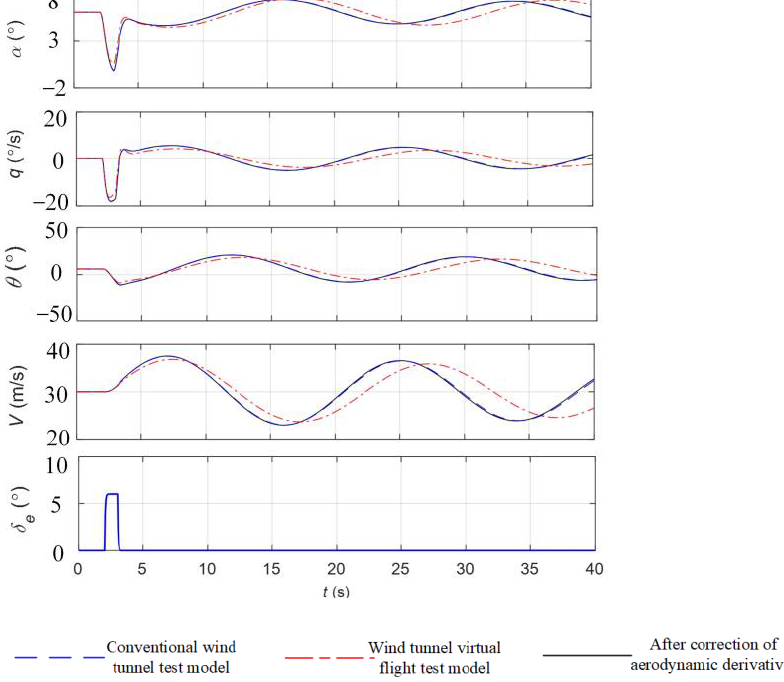
Figure 14. Comparison between the identification model and conventional wind tunnel model.